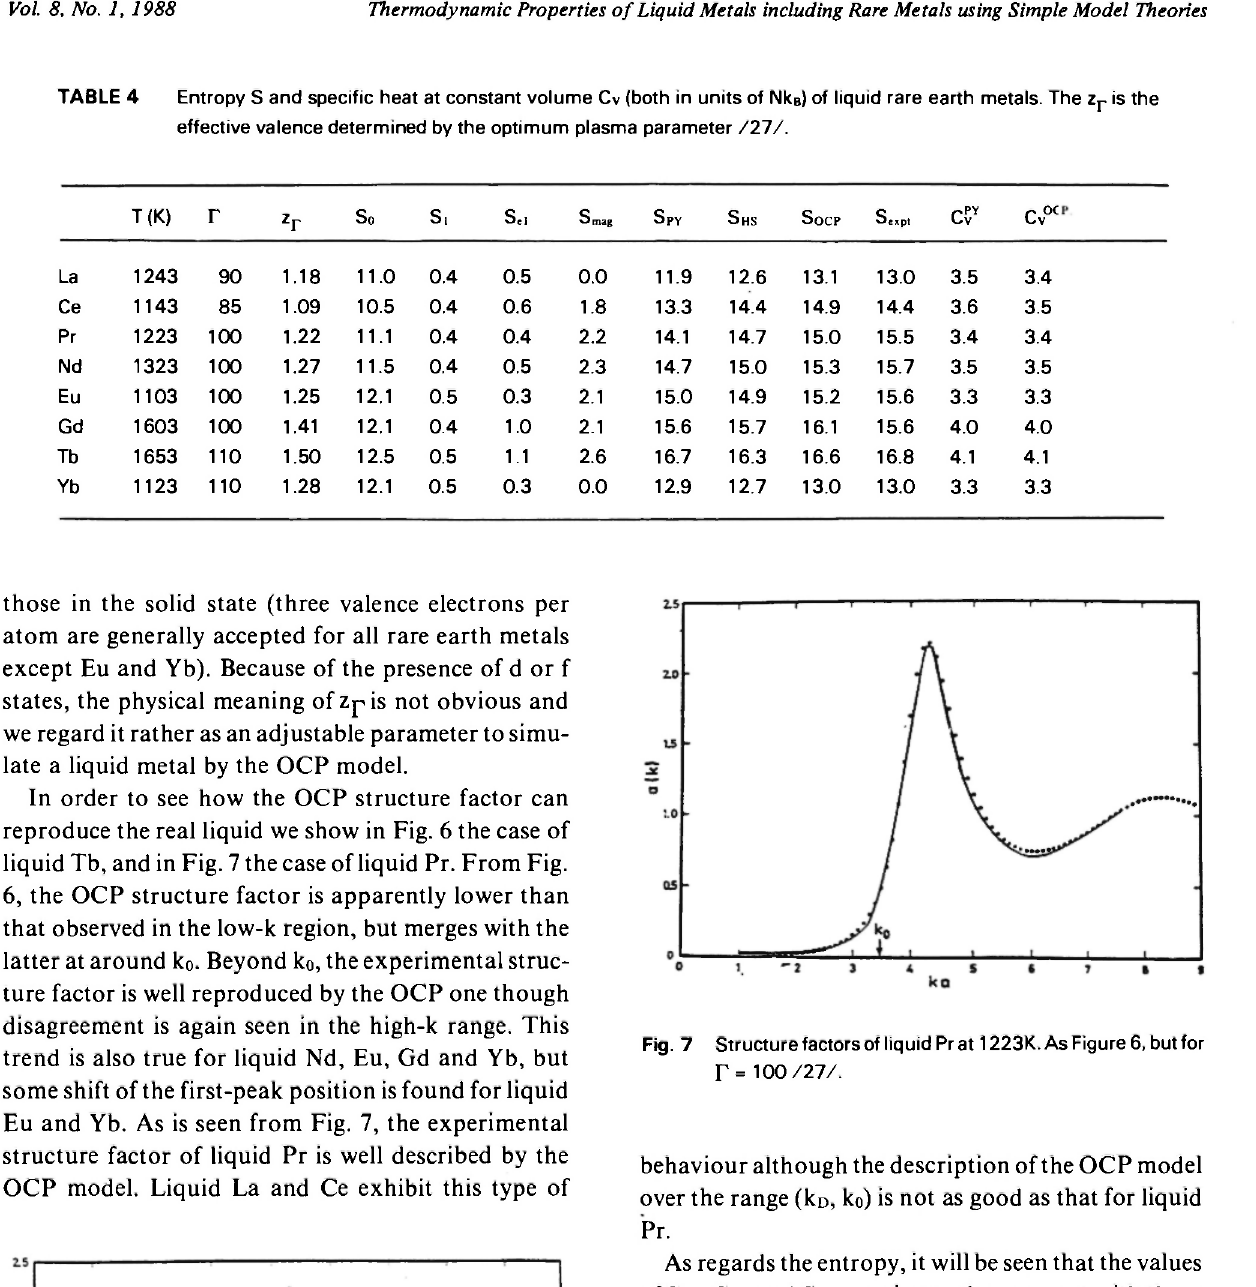
Fig. 7 Structure factors of liquid Pr at 1223K. As Figure 6, but for Γ= 100/27/.